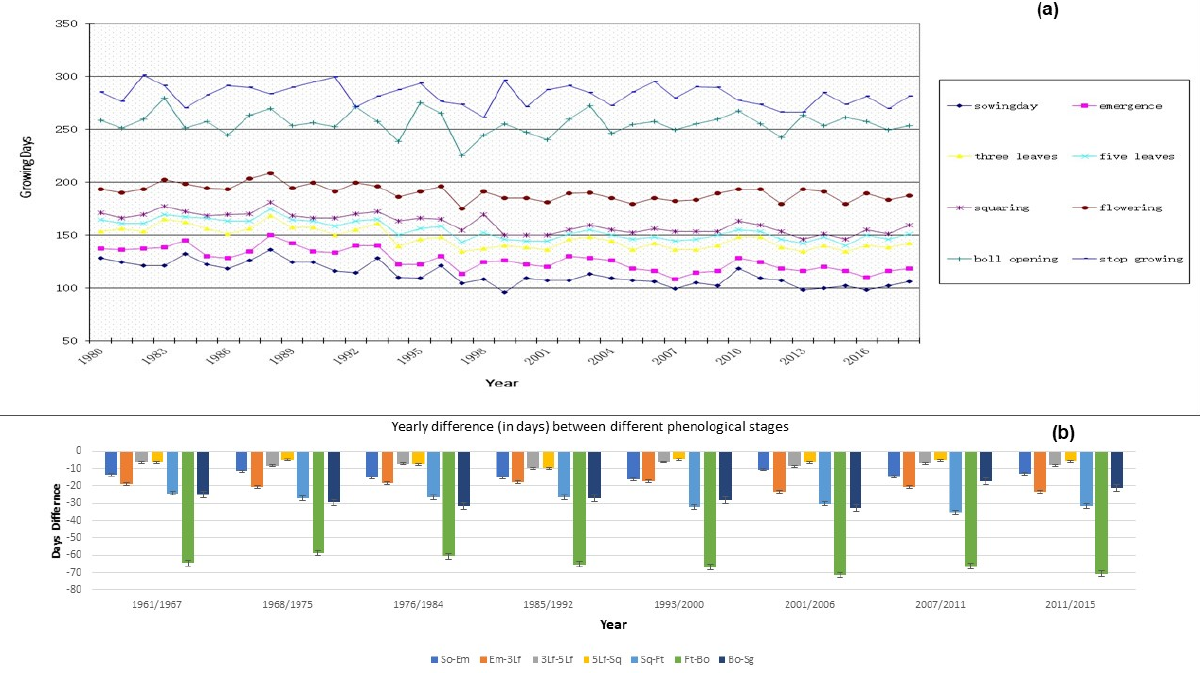
Figure 5. Trends observed in experimental changes in phenological stages of cotton sown ( a ) in Xinjiang during 1980–2018, and ( b ) in Punjab during 1961–2015 time period ( p = 0.05).